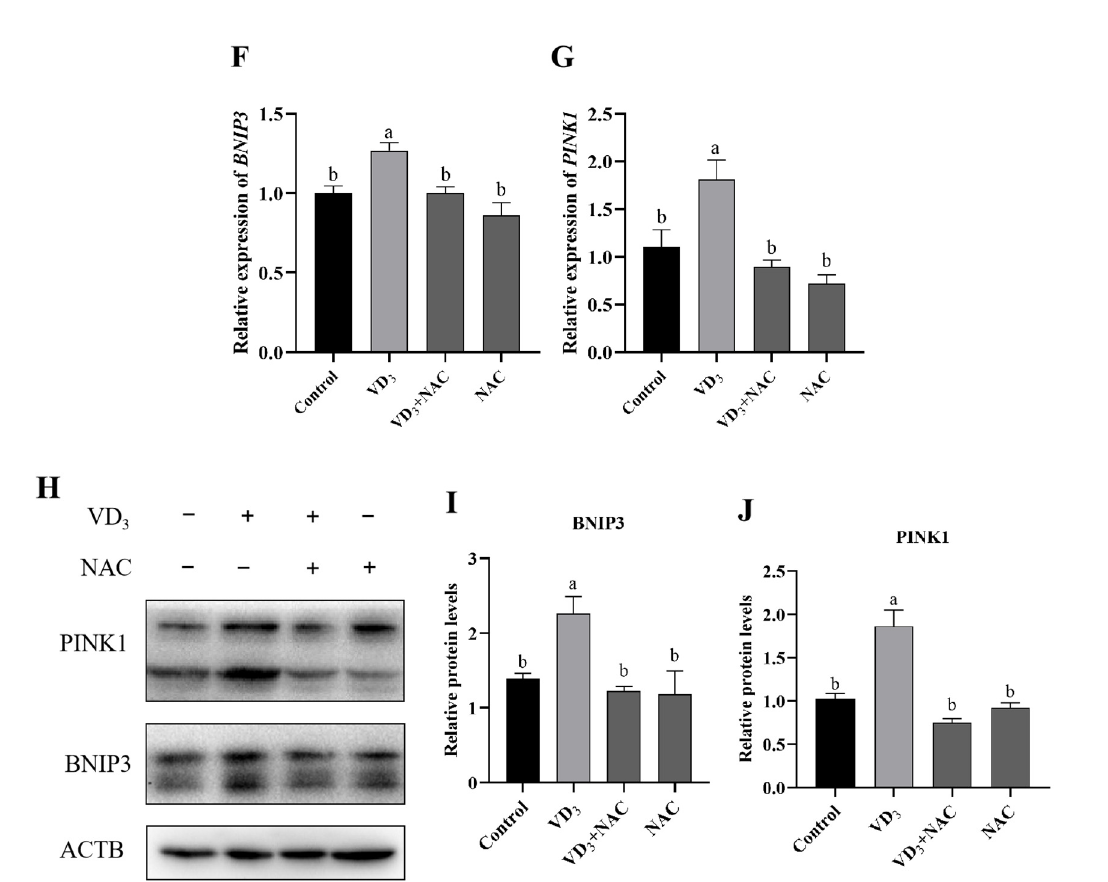
Figure 7. 1 α ,25(OH) 2 D 3 induces mitophagy in PGCs through the ROS ‐ BNIP3 ‐ PINK1 signaling pathway. The relative gene expression of BNIP3 ( A , F ) and PINK1 ( B , G ) in PGCs. Western blotting was used to identify the protein level ( C , H ), and the protein contents of BNIP3 ( D , I ) and PINK1 ( E , J ) were evaluated in PGCs. VD 3 : 1 α ,25(OH) 2 D 3 . NAC: N ‐ acetylcysteine. Different letters on the bar indicate a significant difference. Data are means ± SE of three independent replicates ( p < 0.05).